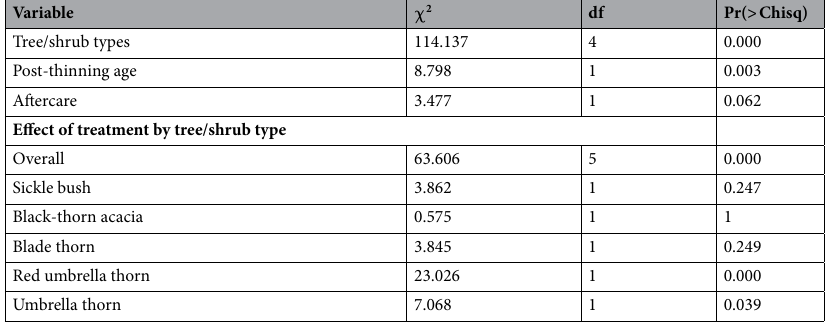
Table 4. Hypothesis tests of the estimated generalized linear mixed-effects model (GLMM) coefficients showing overall treatment effects and differences in the abundance of encroacher species in the thinned and non-thinned treatment areas. P -values for the effect of treatment by tree/shrub type were adjusted for multiple testing using the Bonferroni method.